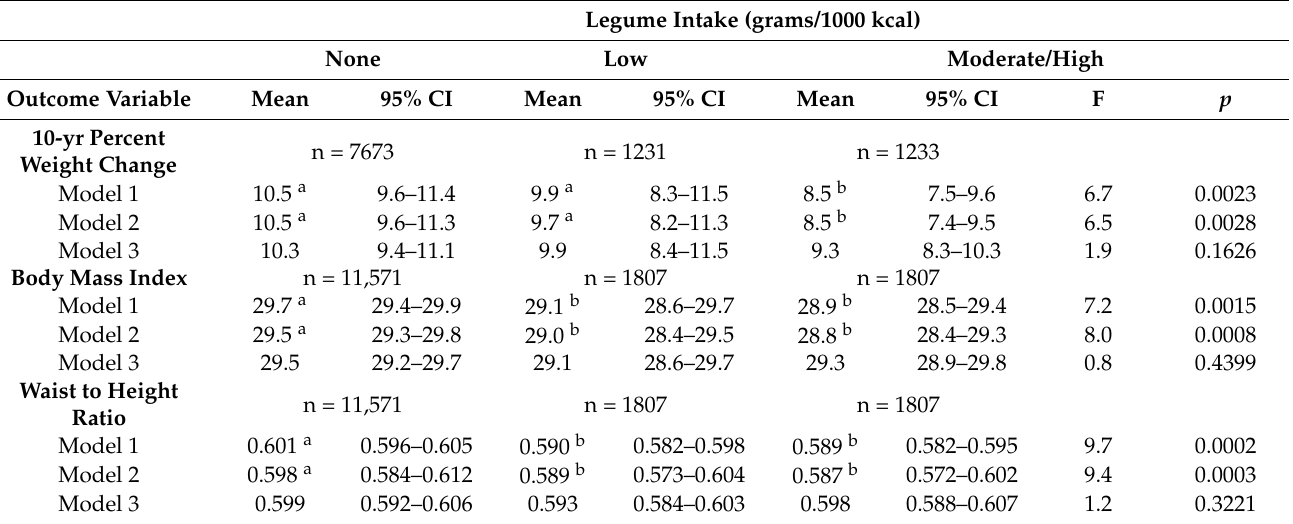
Table 3. Mean differences in 10-year percent weight change, BMI, and the waist-to-height ratio, given 62 degrees of freedom, across categories of legume intake, after adjusting for the